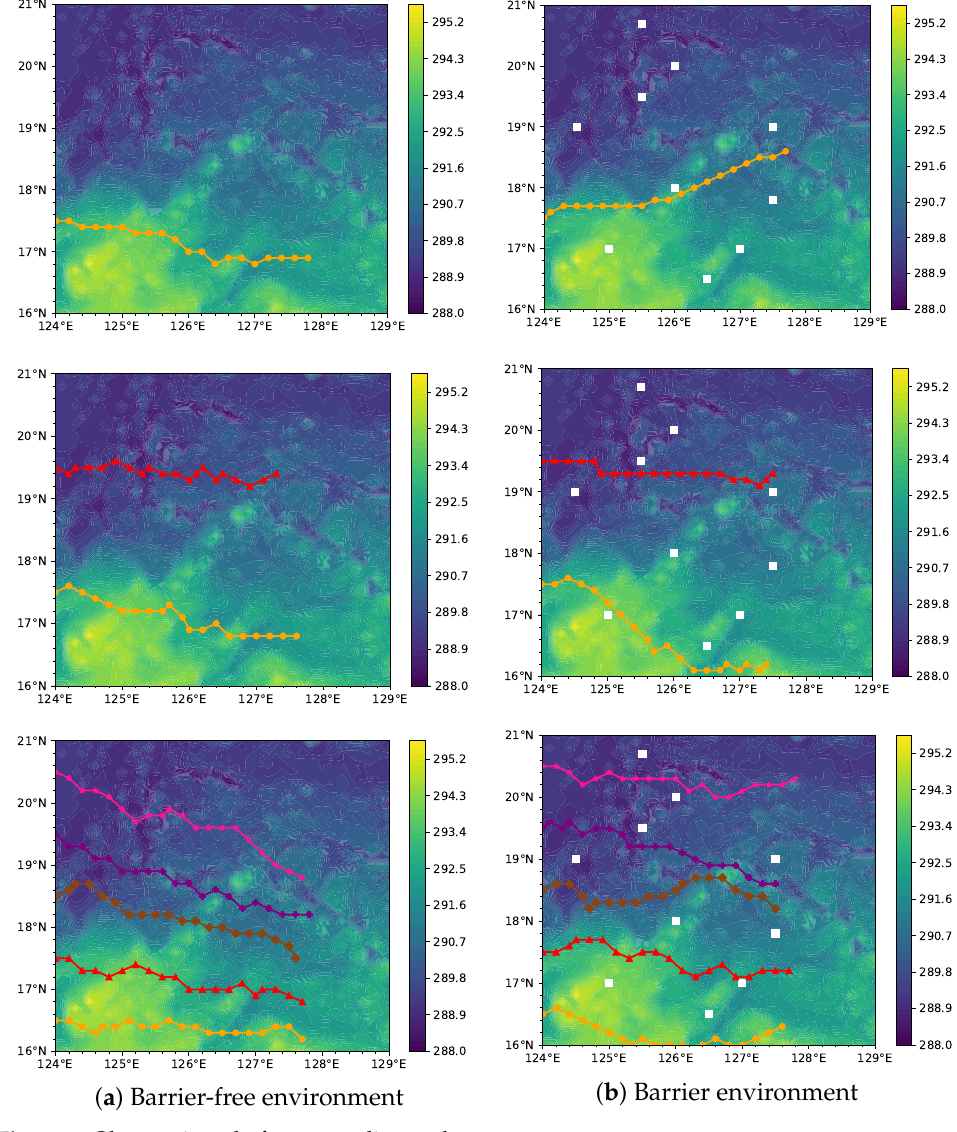
Figure 8. Observation platform sampling path. Table 3. Spring: RMSE comparison of sampling and assimilation results of the observation path between a single platform and multiple platforms, RMSE raw =